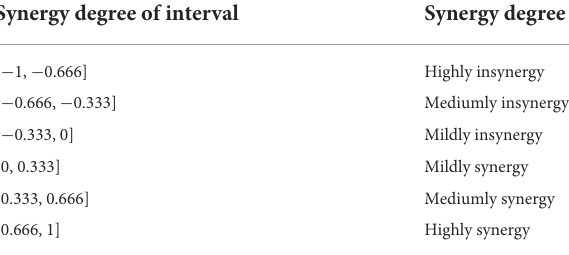
TABLE 5 Criteria for evaluating the synergetic degree of low-carbon development and socio-economic development. Synergy degree of interval Synergy